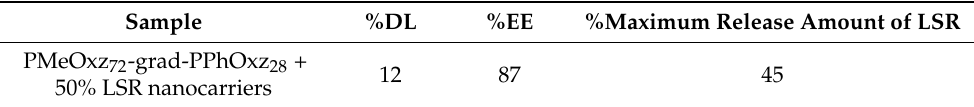
Table 6. Drug encapsulation and release characteristics of LSR loaded in PMeOxz 72 -grad-PPhOxz 28 nanoassemblies in